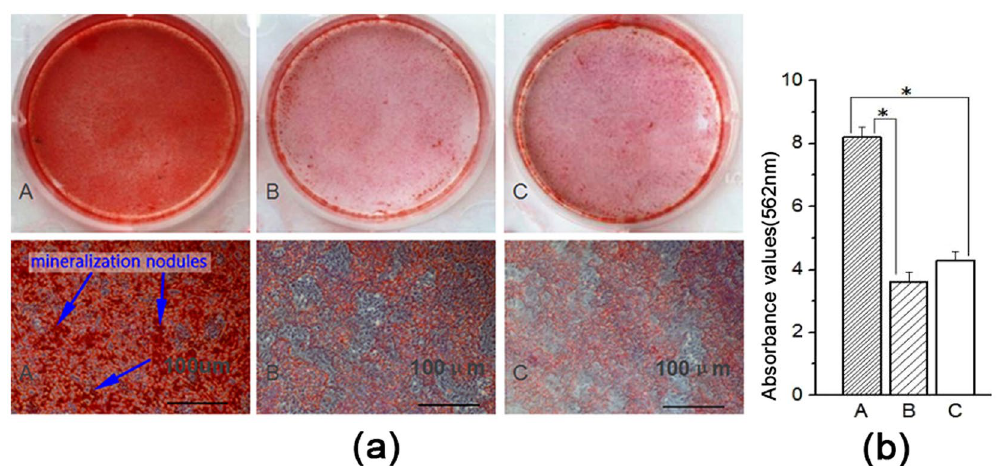
Figure 8. Alizarin Red staining and mineralization assays. ( a ) Extracellular matrix mineralization nodules (blue arrow) of group A were stained intensively and increased visibly; ( b ) Quantitative mineralization deposition of